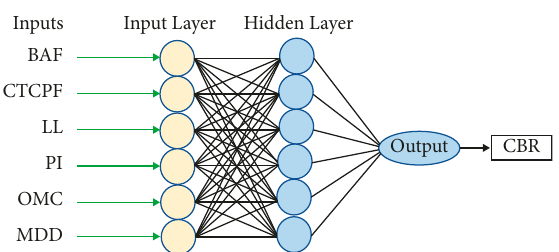
Figure 22: Architecture of the developed ANN model.